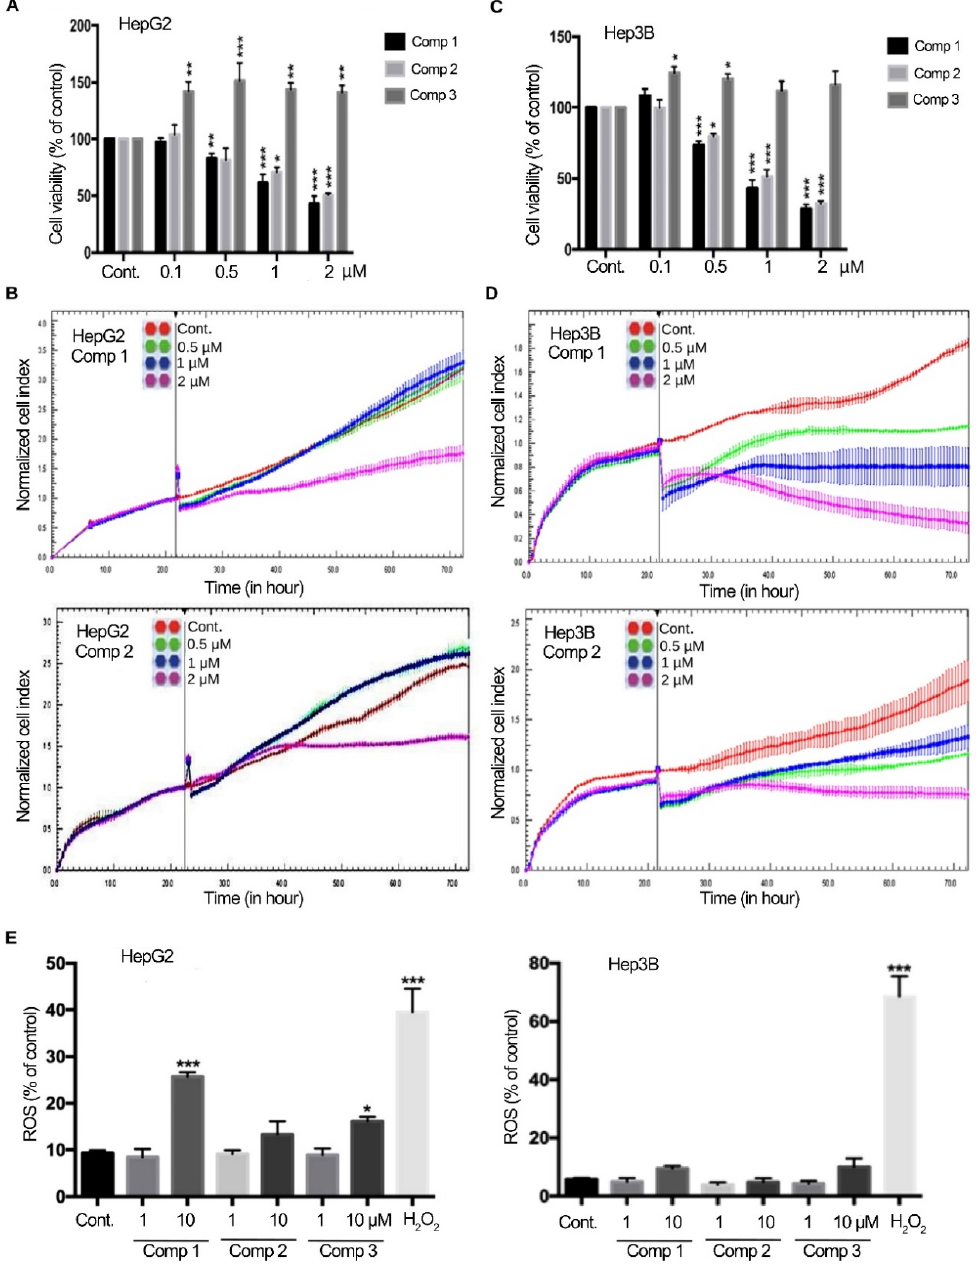
Figure 2. Selected derivatives suppress human hepatocellular carcinoma (HCC) cell viability and growth. ( A , C ) Cells were exposed to different concentrations of compounds for 24 h and cell viability was measured using MTS assays (HepG2 in A and Hep3B in C ). Values (means ± SDs) were obtained from at least three independent experiments. There was a significant decrease in cell viability in cells treated with compounds compared with controls (* p < 0.05, ** p < 0.01, *** p < 0.001). ( B , D ) Cells were treated with compounds 1 and 2 and cell growth was dynamically monitored using impedance technology (HepG2 in B and Hep3B in D ). Normalized cell index values measured over 70 h are shown. ( E ) The percent change in intracellular reactive oxygen species (ROS) generation was measured after cells were treated for 1 h with selected derivatives.